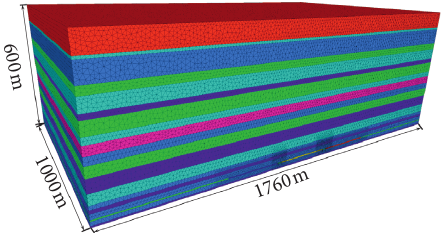
Figure 16: Constructed FLAC3D